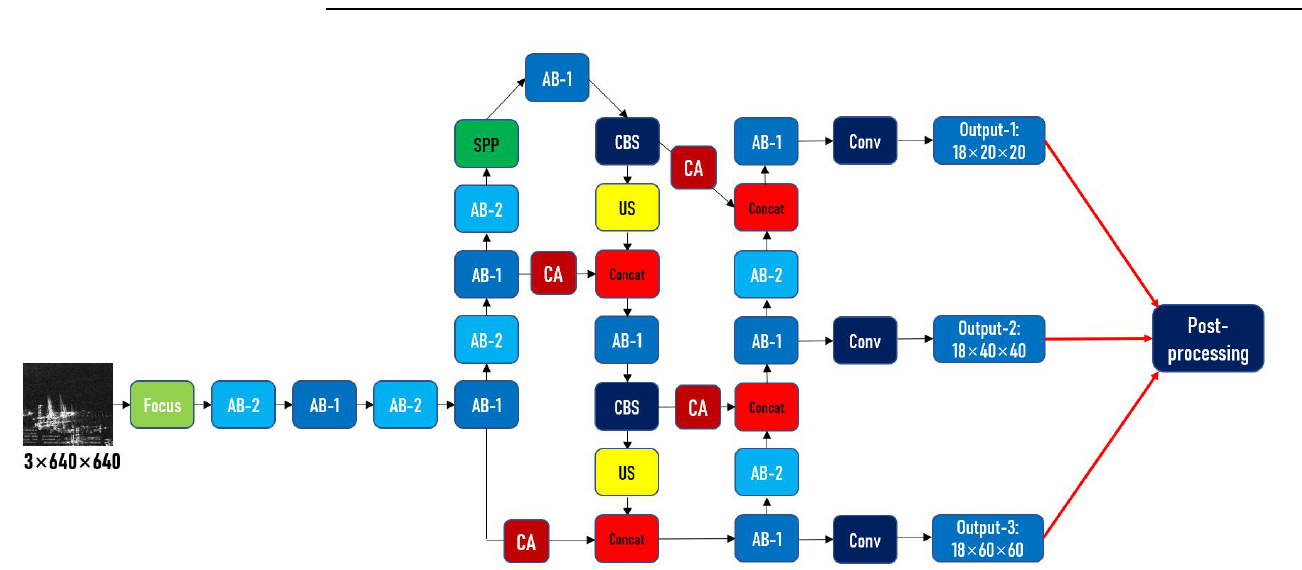
Figure 8. Illustration of the structure of the proposed